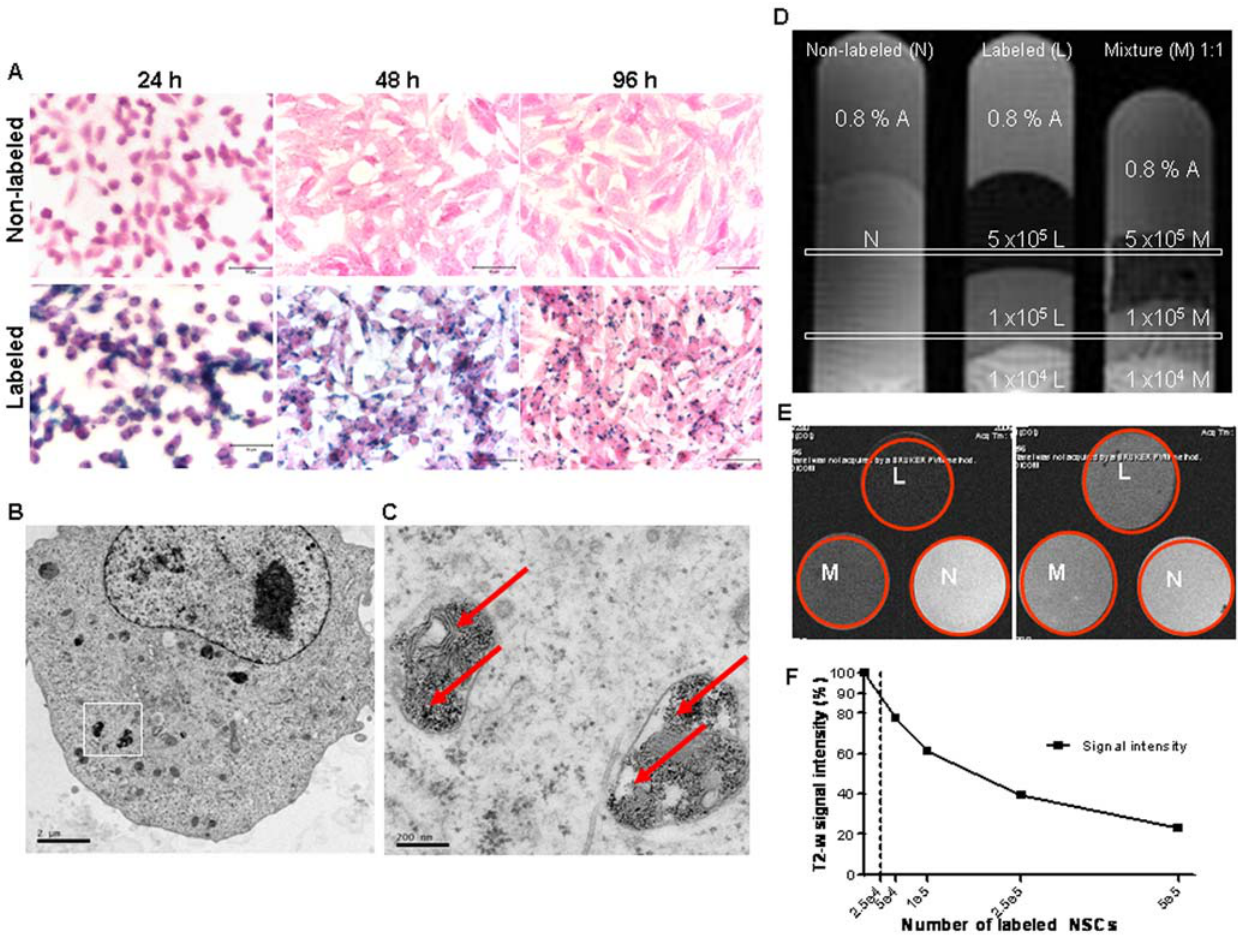
Figure 2. Labeling efficiency of FE-Pro. (A) Light microscopy images of Prussian blue-stained non-labeled and FE-Pro-labeled NSCs at 24, 48 and 96 hours after labeling. (B) Electron micrographs of Fe-Pro-labeled NSCs. (C) Higher magnification image of outlined area in (B). Red arrows point to internalized FE-Pro complex in membrane-bound organelles. (D–E) T2-weighted MR images of labeled (L), non-labeled (N), and an equal mixture (M) of NSCs grown in soft agar. Each phantom contained three different total numbers of NSCs (1 6 10 4 , 1 6 10 5 and 5 6 10 5 ) each in 500 m l of 20% DMEM and 0.8% agar. Coronal view (D) and axial view at 5 6 10 5 (E. left) and 1 6 10 5 (E. right) of the phantoms. Decrease in T2-w signal strength correlated with the number of labeled cells in the phantom. (F) Graph of T2-w signal intensity vs. number of labeled NSCs. Data were extracted from 5 random fields of each corresponding phantom using ImageJ and shown as mean 6 SE. MRI conditions: 7.0 Tesla, Gradient-Echo sequence, voxel size=0.09 mm 3 , TR/TE=5402.5/90 ms. Scale bars=50 m m (A) , 2 m m (B) and 200 nm (C)